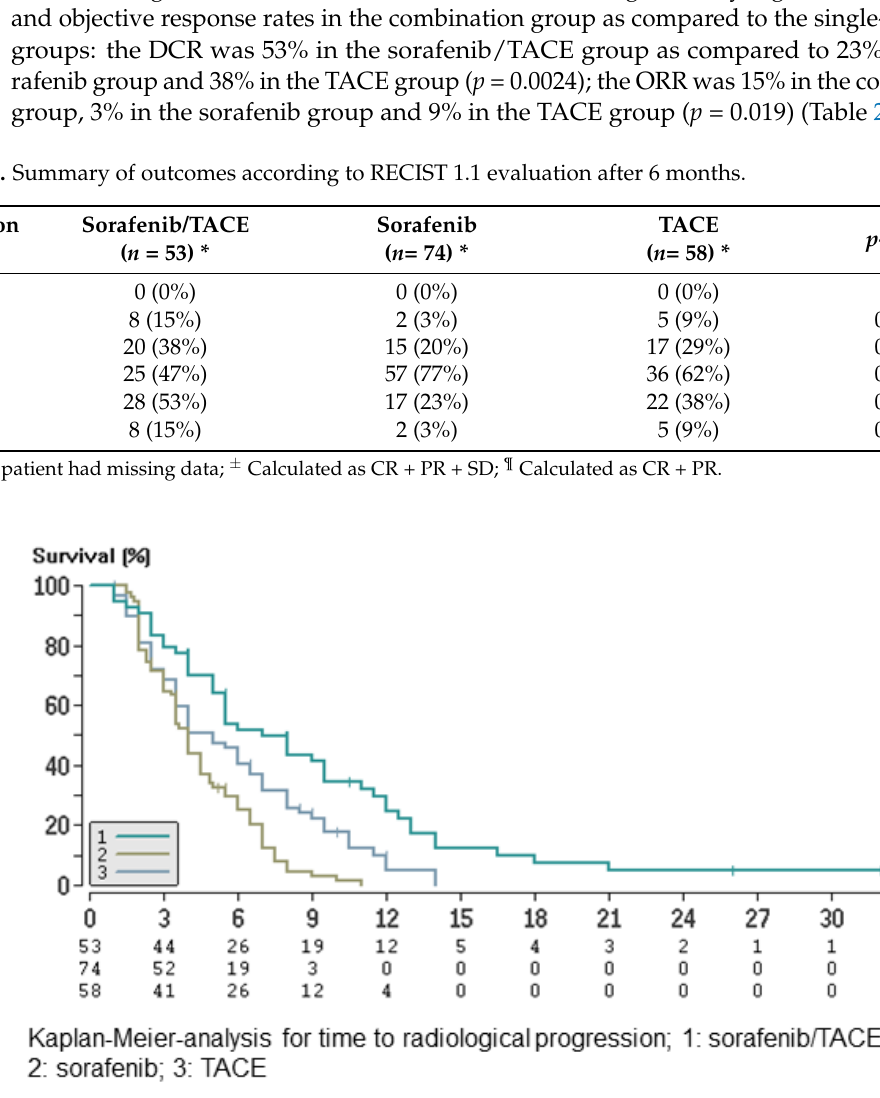
Figure 2. Time to radiological progression.